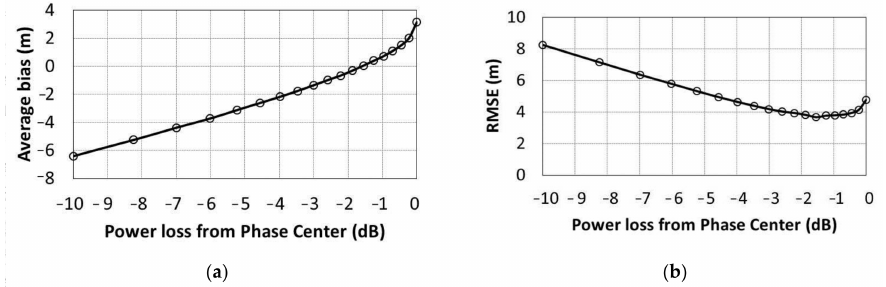
Figure 6. Average bias and root mean square error (RMSE) in 314 deg. flight direction ( a ) Stand height average bias and ( b ) RMSE versus power loss with respect to stand average canopy phase center elevation.